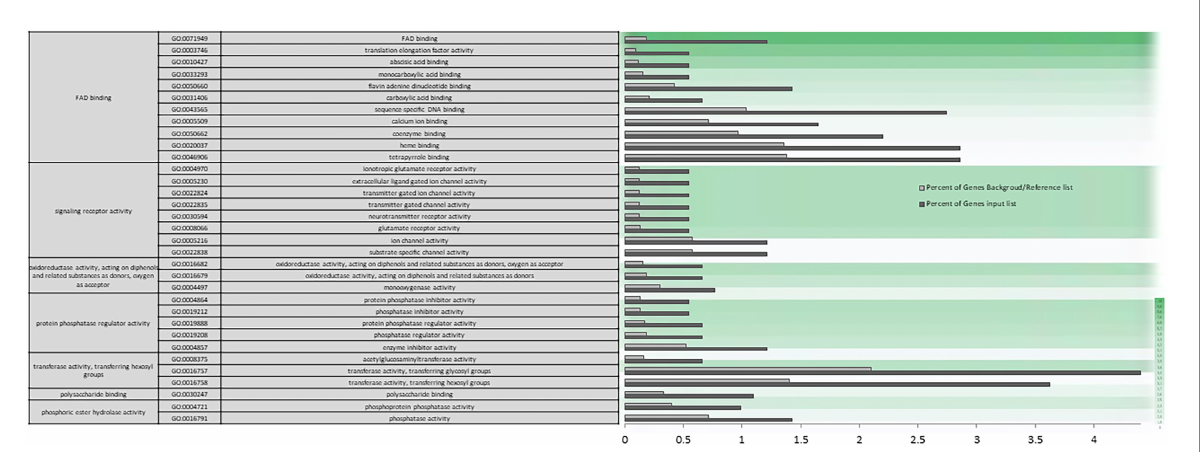
FIGURE 10 Specific gene ontology enrichment obtained for firmness using Weighted Gene Correlation Network Analysis. Bar chart showing in detail the most significant molecular function terms overrepresented obtaining by a Singular Enrichment Analysis (SEA; FDR ≤ 0.05) in WGCNA. The Y -axis shows the definition of GO terms. The X -axis is the percentage of genes mapped by the term, and represents the abundance of the GO term. The percentage for the input list is calculated by the number of genes mapped to the GO term divided by the number of all genes in the input list. The same calculation was applied to the reference list to generate its percentage. These two bars are classificated by a color key showing a green gradient scale for the frequency between both percentages